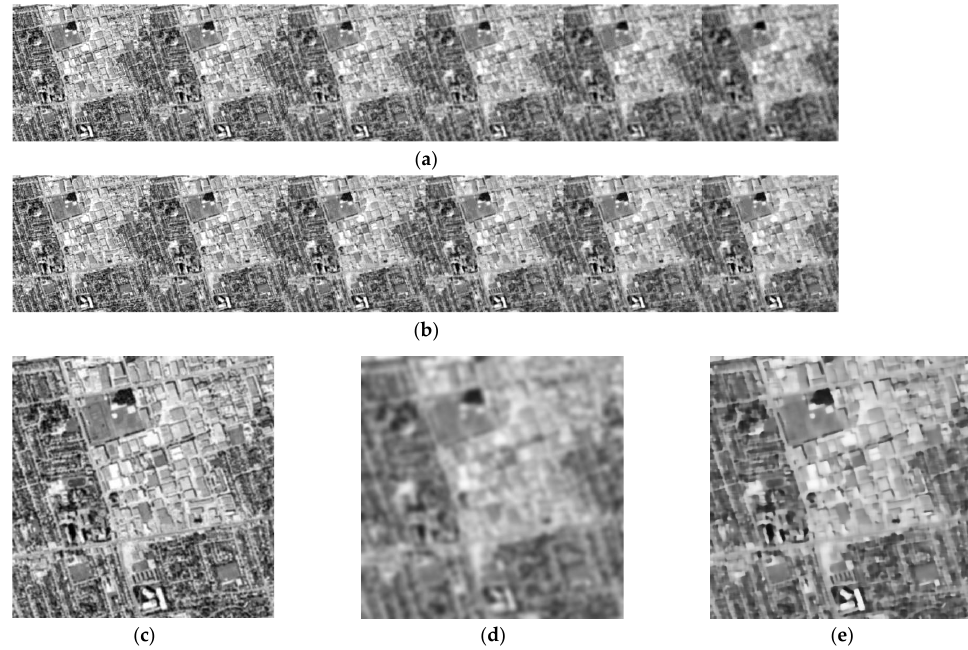
Figure 2. Comparison results of GSS and NDSS: ( a ) GSS; ( b ) NDSS; ( c ) Optical image; ( d ) The fifth layer of GSS; ( e ) The fifth layer of NDSS.